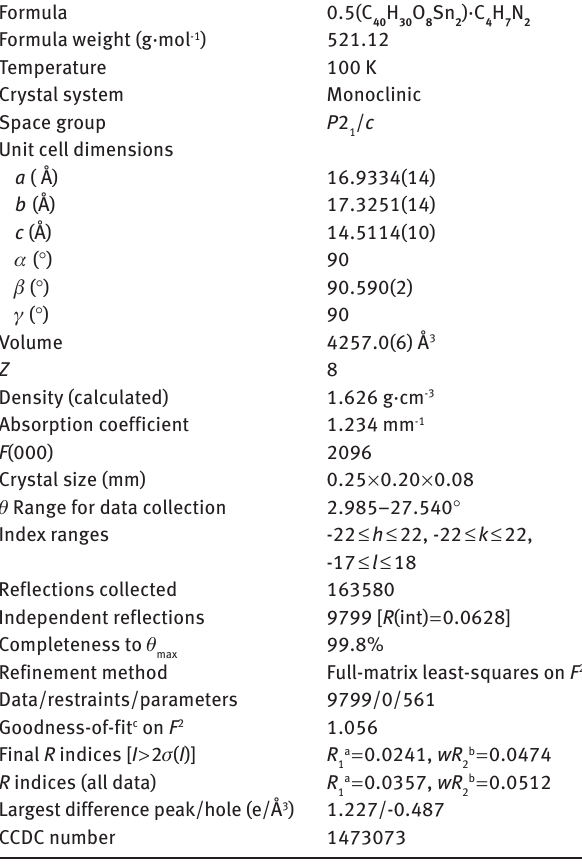
Table 1: Crystal data and structure refinement of 1 . Formula